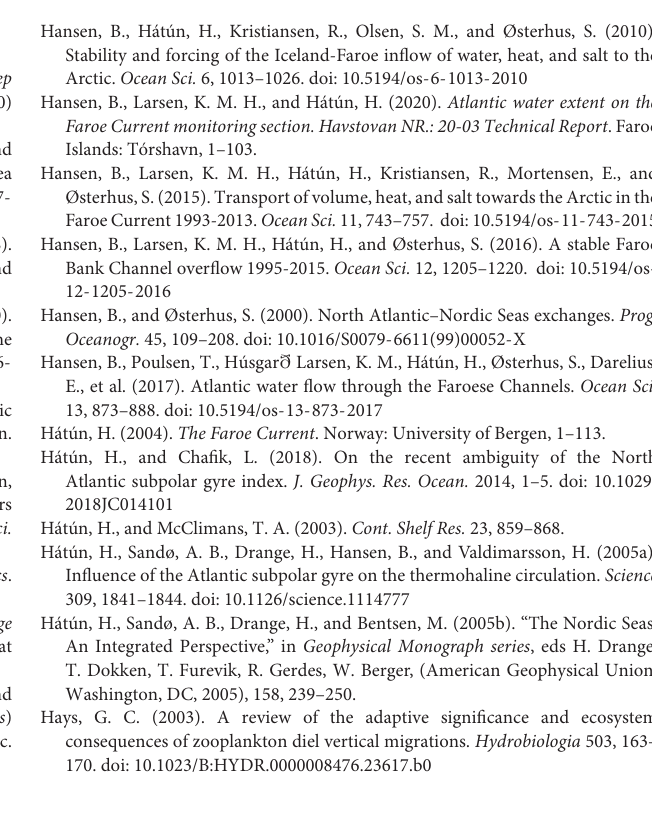
Supplementary Figure 1 | Averaged (over 103 complete transects) geostrophic current velocities, relative to 1300 m depths. Dark red color shows that velocities increase up through the water column, while the other colors demonstrate that velocities decrease up through the water column in the NSG rim. (The tick marks on the x -axis are the same as in Figure 4 ). Supplementary Figure 2 | (a) Correlation coefficients between surface geostrophic currents based on hydrography (relative to 1300 m), SSH gradient (altimetry), respectively. Both are calculated between the standard hydrographic stations, and a daily satellite altimetry product is used. (b) Time lags between hydrography and altimetry, where the highest correlation coefficient is obtained (positive values show that hydrography leads). In the NSG rim, the water column density profile leads the SSH by about a week (b) . We interpret this curious fact as follows: the vorticity input from winds is efficiently transmitted to the bottom, where the local slope of the f / H field, through bottom Ekman dynamics, set up near-bottom currents (Nøst and Isachsen, 2003) which subsequently translate up through the NSG after an inertial time lag – which appears to be about a